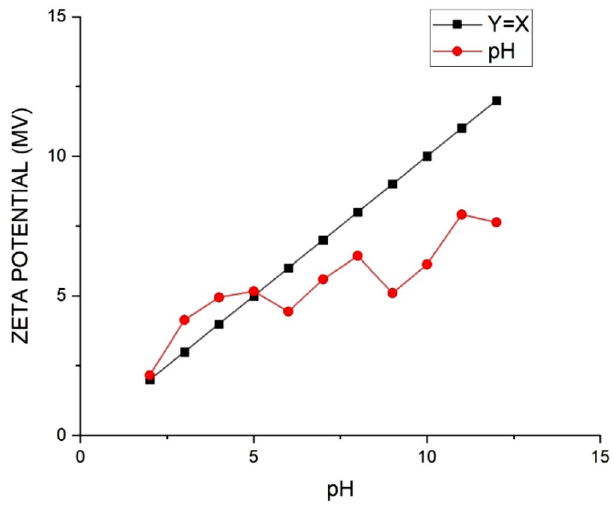
Figure 7. Effect of pH on the zeta potential of UAS MIL-53(Al)